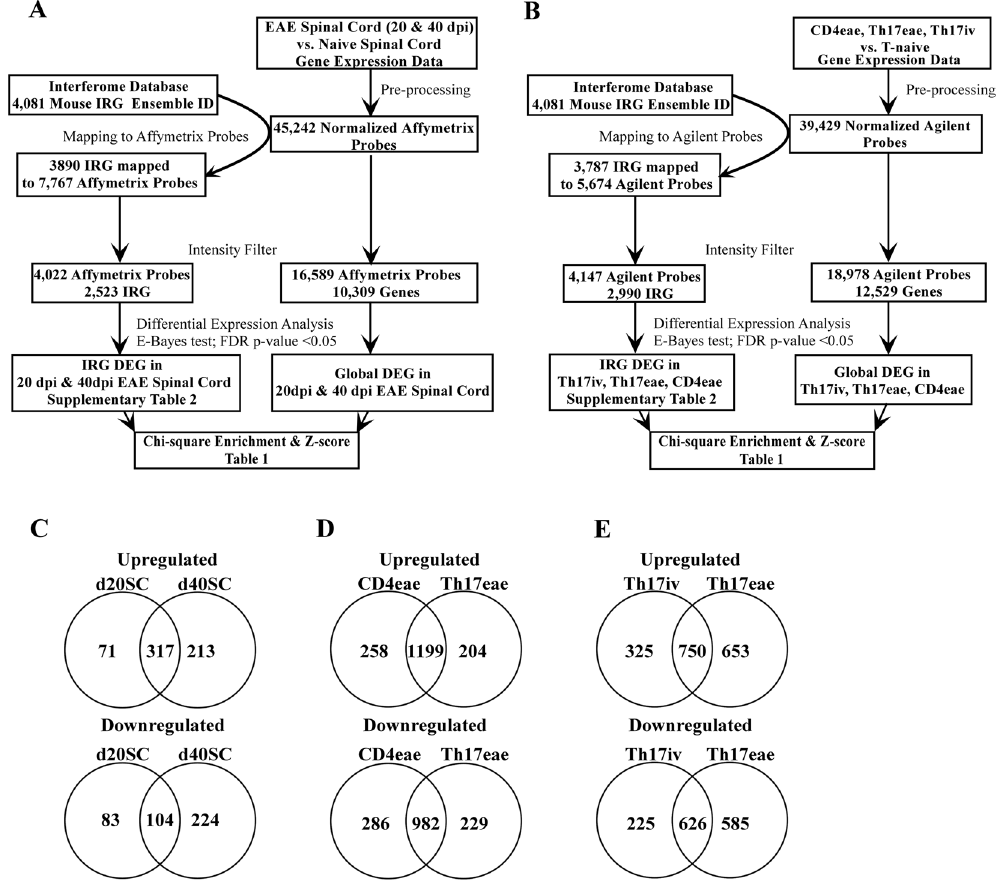
Figure 1. ( A ) Flow chart for the transcriptomics study of mouse spinal cord. ( B ) Flow chart for the transcriptomics study of mouse CD4 T lymphocytes. ( C ) Number of common and unique dysregulated IRG in EAE spinal cord (SC) at day 20 and 40 post immunization. ( D ) Number of common and unique dysregulated IRG in CD4eae and Th17eae T lymphocytes. ( E ) Number of common and unique IRG DEG in Th17iv and Th17eae T